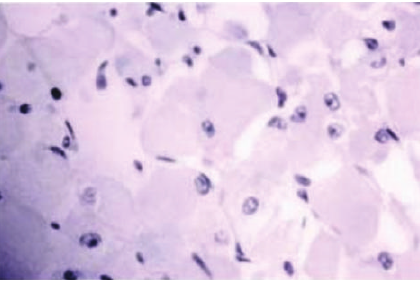
Figure 2: Skeletal muscle (it shows cytoplasmic positivity for MSA,